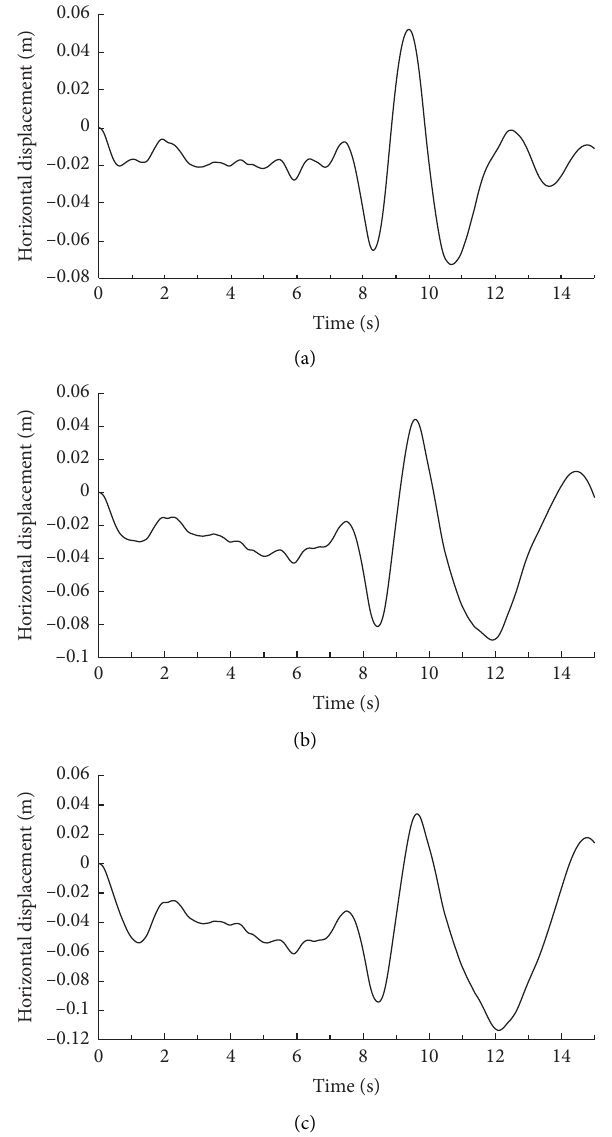
Figure 9: Horizontal displacement-time history curves for (a) the 30m layer at node 456, (b) the 60 m layer at node 261, and (c) the 80m layer at node